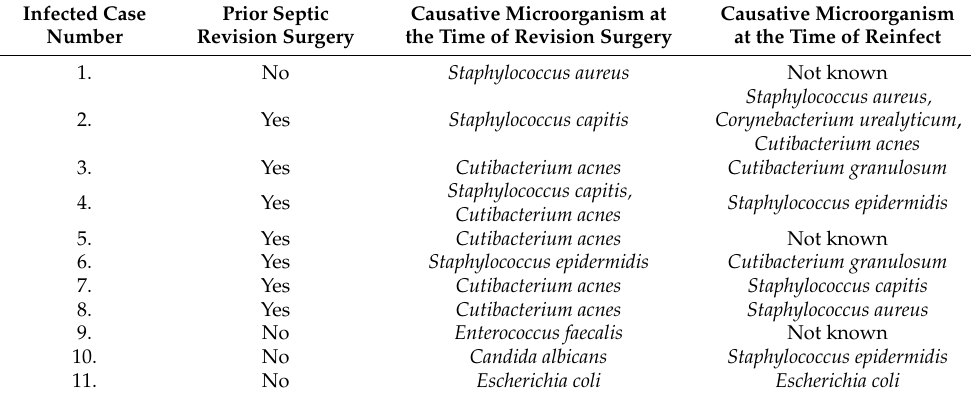
Table 6. Details of cases with persistent infection or